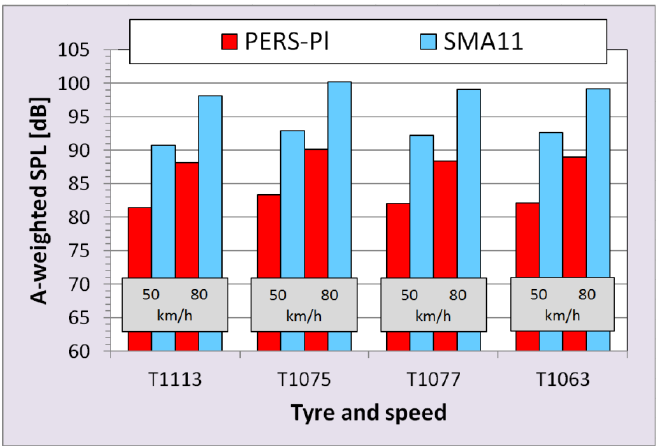
Figure 5. A ‐ weighted SPL for passenger car tires measured by close proximity method of tire/road noise measurements (CPX) method.